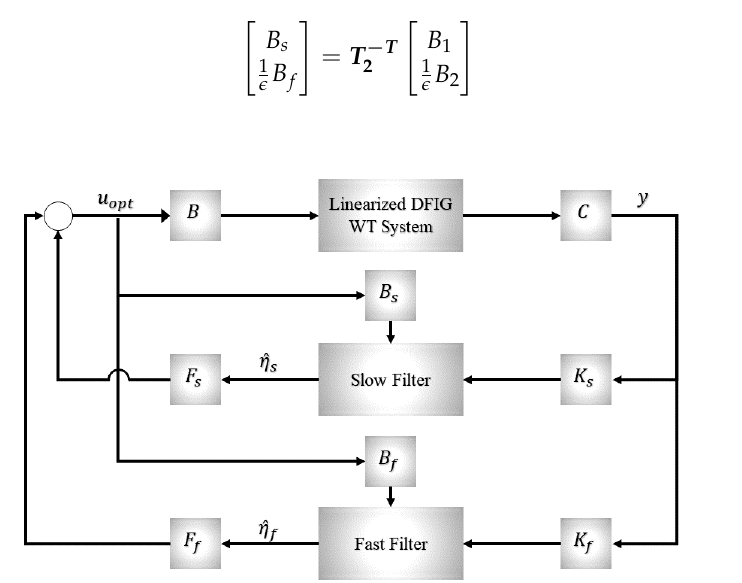
Figure 3. Slow-fast LQG controller structure for DFIG wind turbine